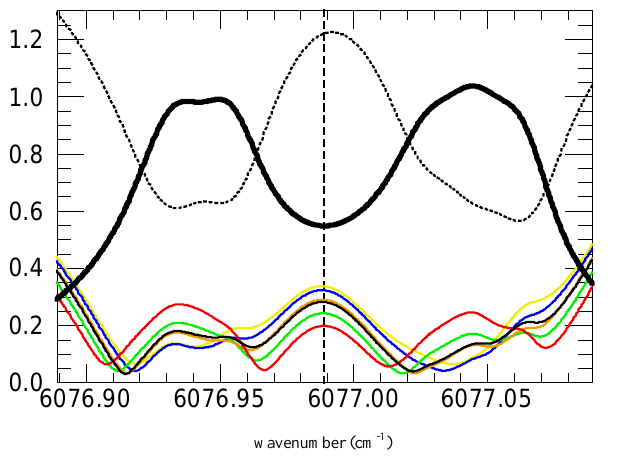
Fig. A2. Optical depth of water vapour absorption lines around the most favorable methane line multiplet at 1645.6nm (black), with relative X CH 4 uncertainty due to uncertainties in the water vapour profiles (colored according to Fig. A1), as function of off- line wavenumber. The dotted vertical lines indicate the two closest off-line wavenumber candidates which minimize the uncertainty in the considered range of atmospheric states, thanks to the “water sen- sitivity cancellation” effect described in the text. The arrows point at the corresponding slightly positive water vapour differential op- tical depth for these online/offline